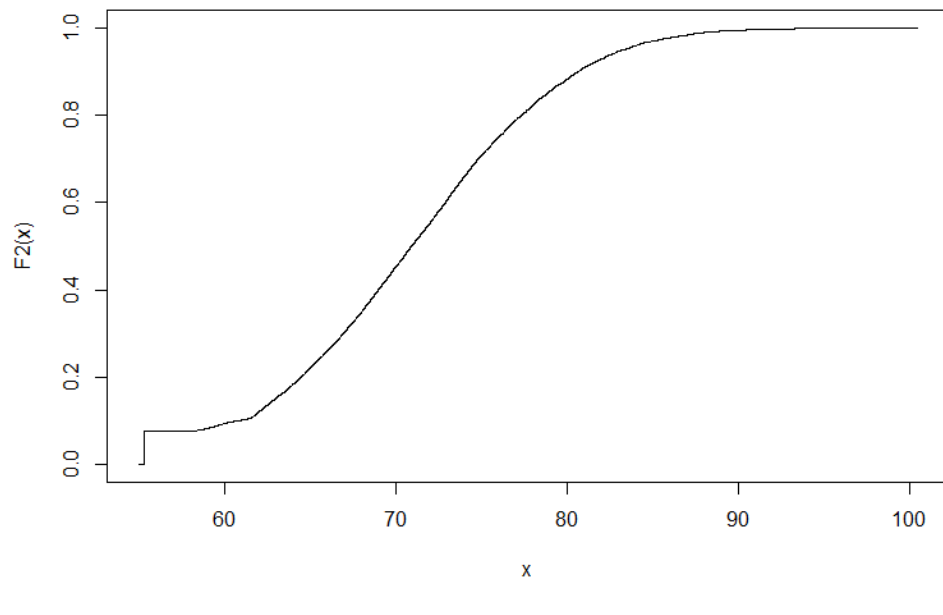
Figure A3. The F 2 bid distribution, source: own figure.